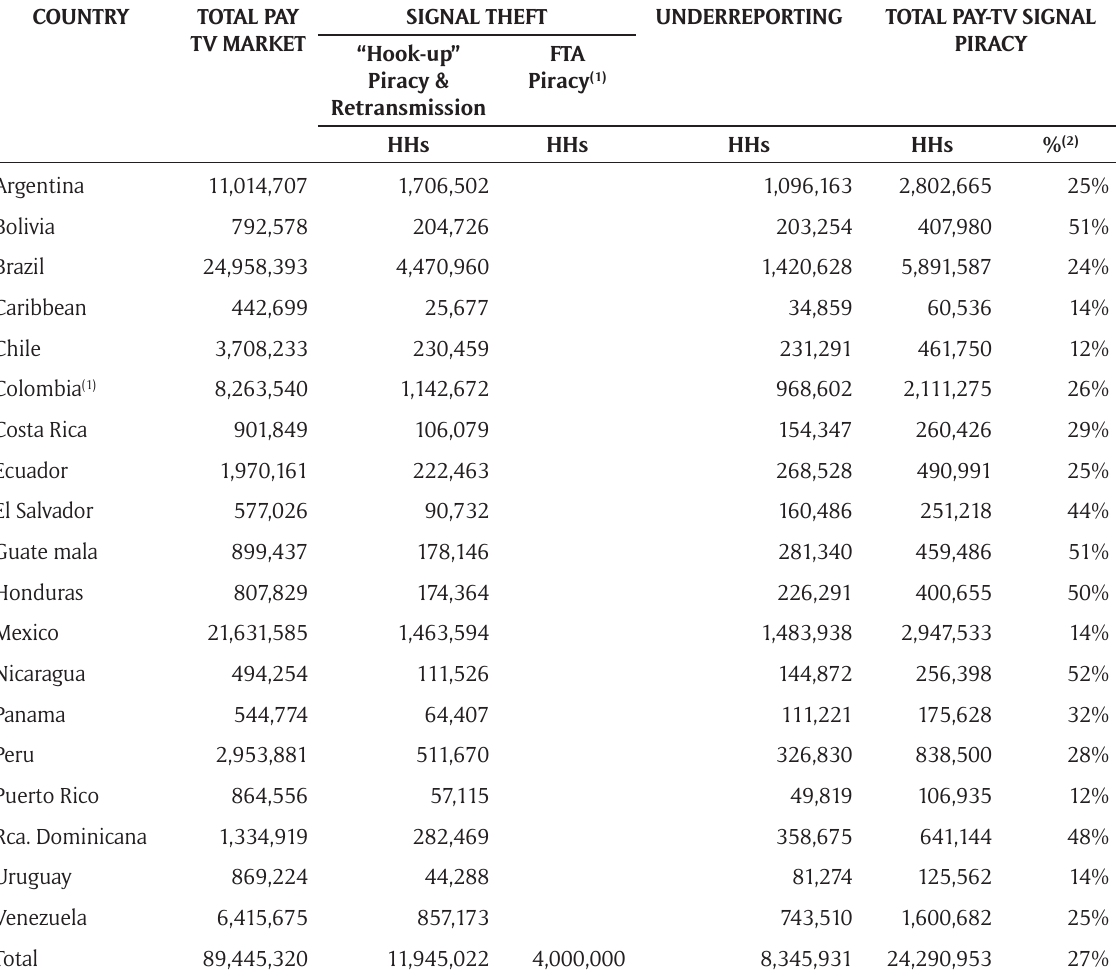
Table 1: Pay-TV signal piracy penetration in Latin America and the Caribbean (excluding online piracy). PAY-TV SIGNAL PIRACY PENETRATION IN LATIN AMERICA AND THE CARIBBEAN (EXCLUDING ONLINE